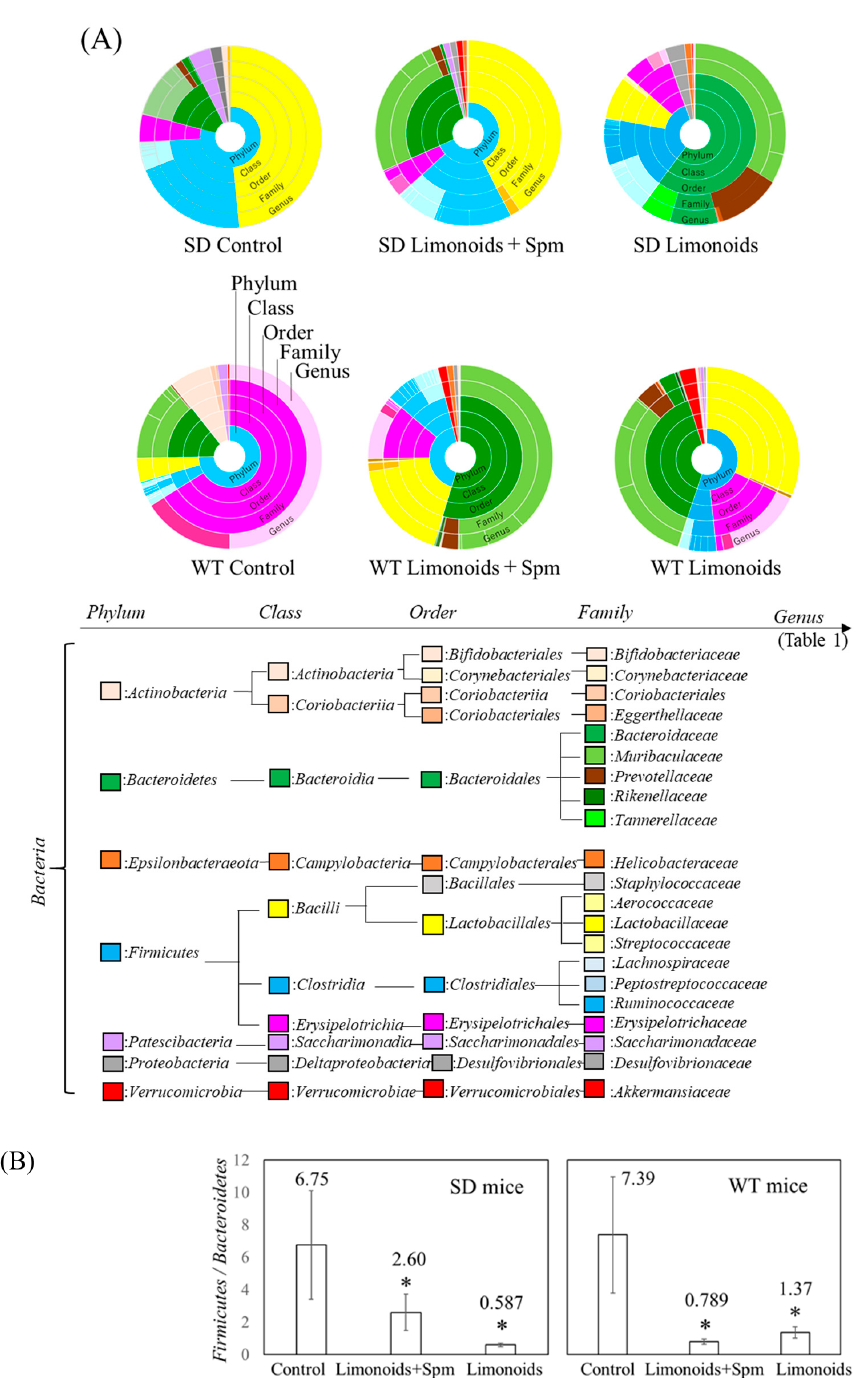
1.37 ± 0.159; p < 0.05).